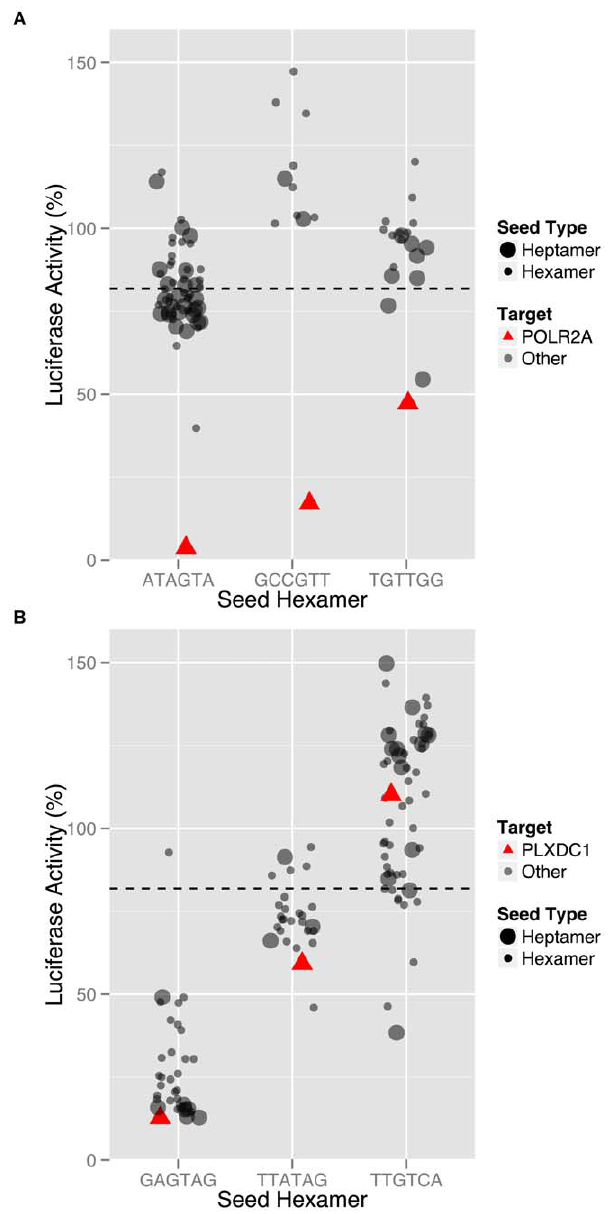
Figure 2. Examples selected for test set. Common seed analysis plots for two genes which had an siRNA showing significant knockdown (greater than 2-fold decrease in luciferase signal in comparison to non-silencing control). The dashed line represents the median response for the whole genome library. ( A ) POLR2A was selected as a true positive because multiple siRNAs generated the same phenotype, the role of RNA polymerase in transcription is already established, and siRNAs containing the same seed sequences (grey circles) did not show a trend towards inhibition of the reporter. ( B ) In contrast, PLXDC1 was selected as a false positive because it has no known role in transcription, other siRNAs against the same gene fail to elicit the same phenotype, and there is an obvious trend of down- regulating the reporter for all other siRNAs containing the same hexamer (GAGTAG) or heptamer seed